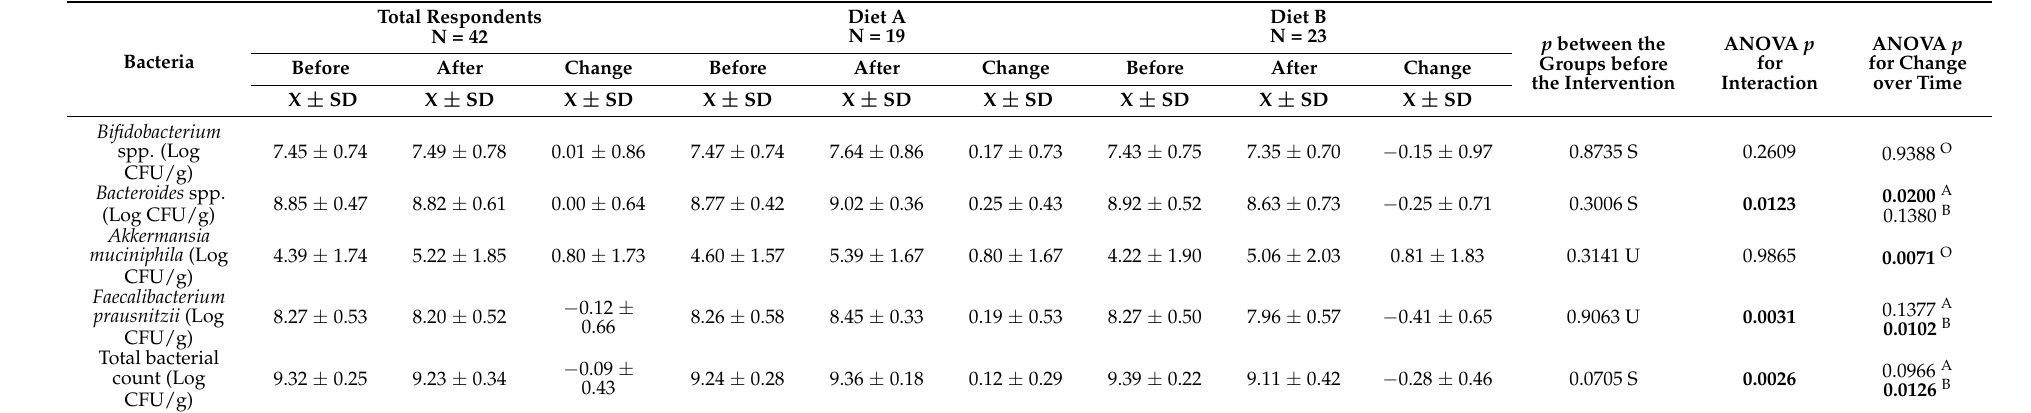
Table 4. Intestinal microbiota of study participants before and after 3 months of dietary